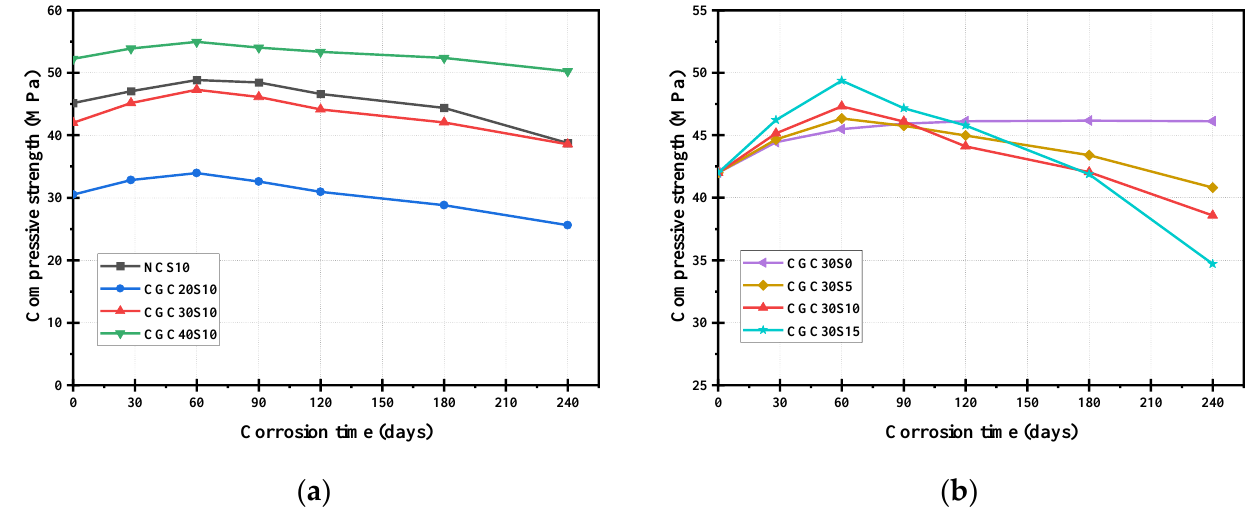
Figure 6. Compressive strength of specimens at different corrosion times under sulfate attack: ( a ) different concrete; ( b ) different sulfate concentration.